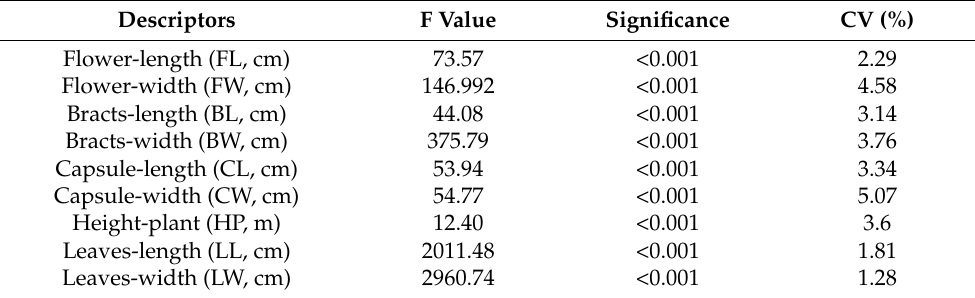
Table 2. F value results of the ANOVA performed on quantitative descriptors obtained when compar- ing species of Gossypium spp. collected in the province of La Convenci ó n, in the districts of Echatari and Megantoni,